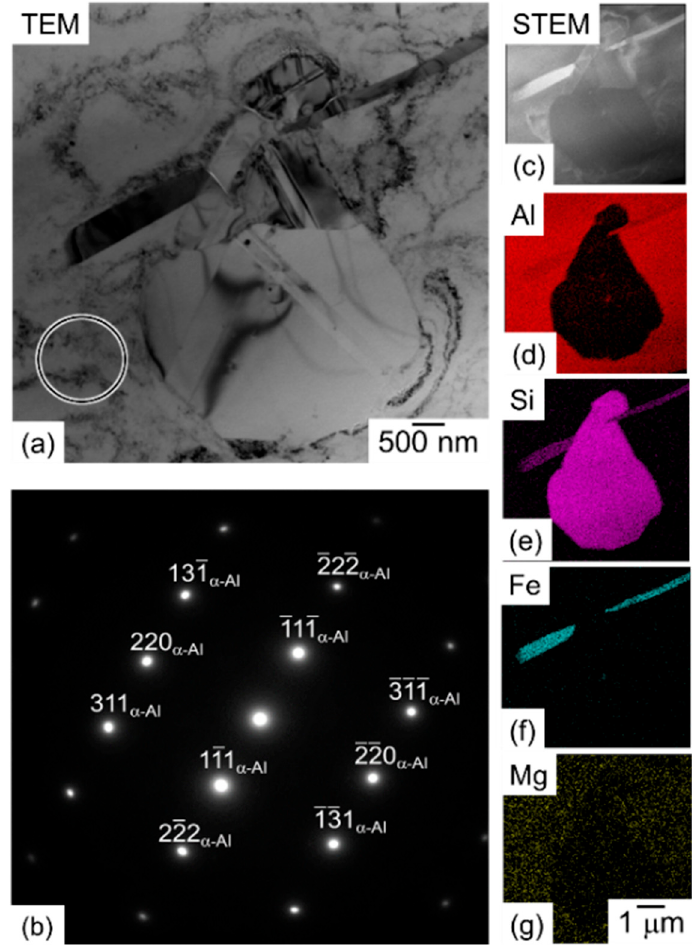
Figure 4. ( a ) TEM bright-field image of the microstructure taken from the node portion of the lattice specimen solution treated at 530 ° C for 6 h with the vertical distance from the geometric center: d N = 0.8 mm. ( b ) Selected area electron diffraction (SAED) patterns from the region marked with a circle in ( a ). ( c ) STEM-HAADF (scanning transmission electron microscopic high-angle annular dark-field) image and (d–g) the corresponding EDS elemental mapping images of ( d ) Al, ( e ) Si, ( f ) Fe, and ( g ) Mg.